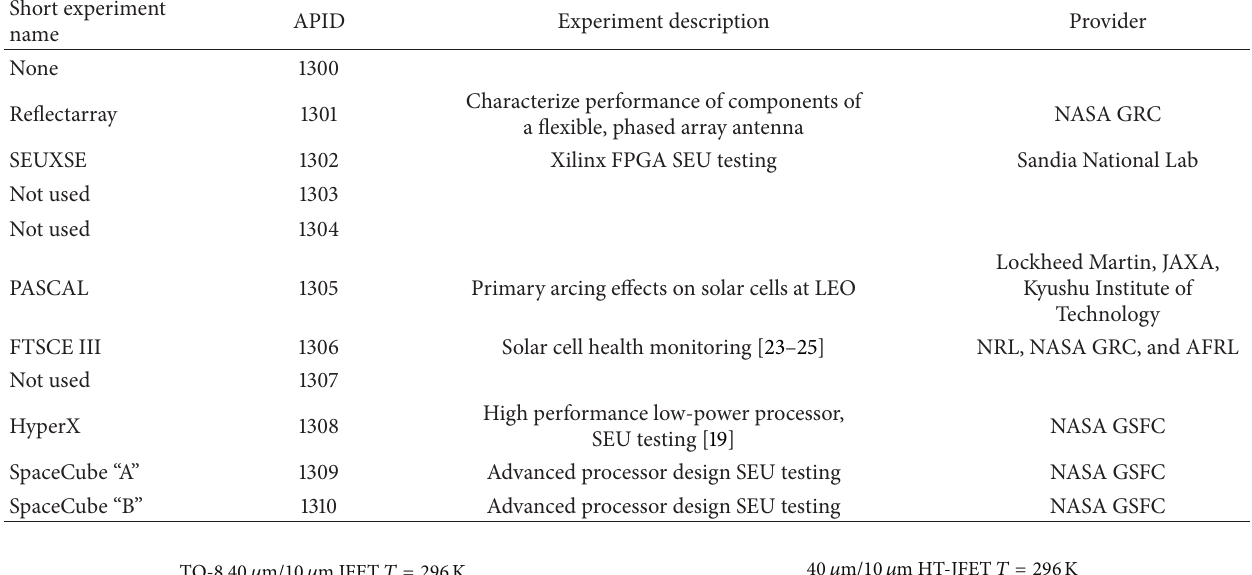
Table 4: Materials on the International Space Station Experiment Eight (MISSE8) flown on ISS from May 2011 to present (April 2013).